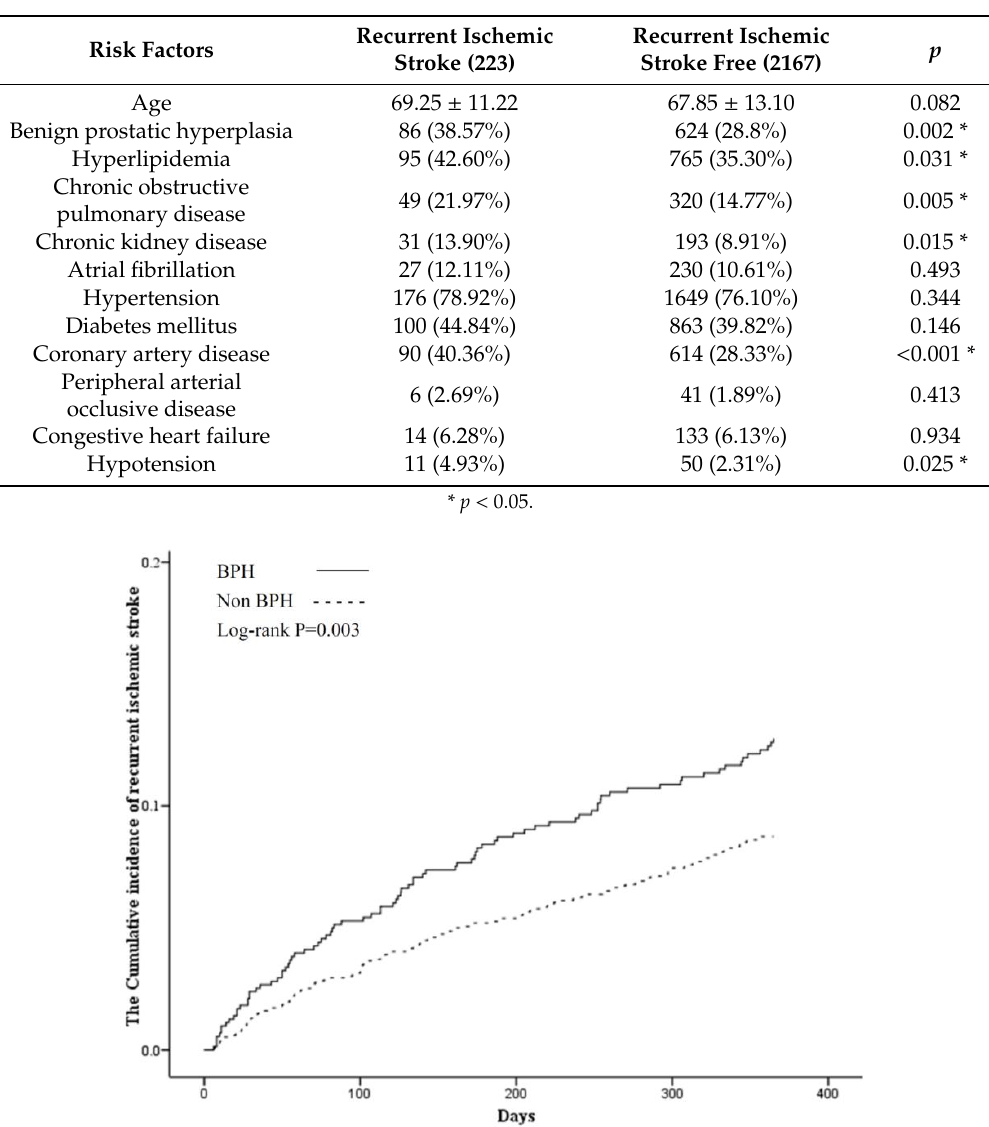
Table 1. The characteristics between recurrent ischemic stroke and non-recurrent ischemic stroke.